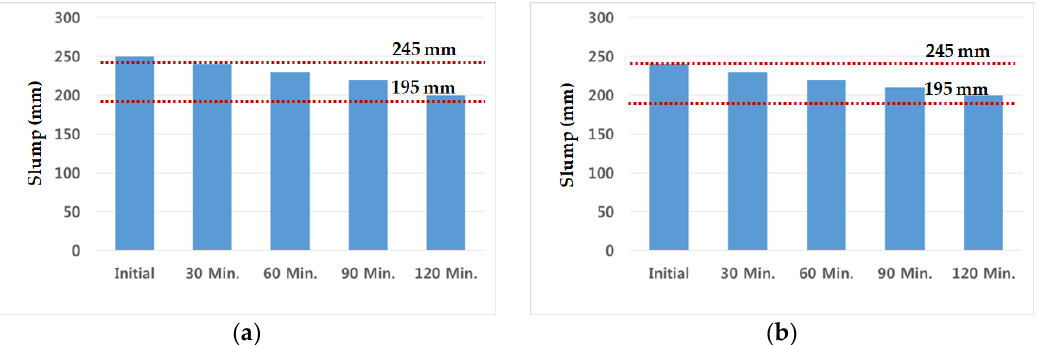
Figure 5. Slump test ( a ) C40-1 (GGBS 50%, Daracem 208) ( b ) C40-2 (GGBS 65%, Daracem 208).